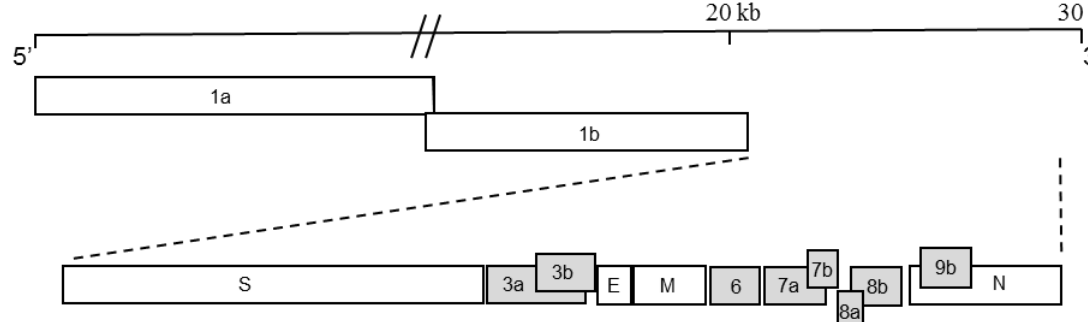
Figure 1. Organization of severe acute respiratory syndrome coronavirus (SARS-CoV) genome showing the position of the accessory genes. The eight accessory open reading frames (ORFs) (grey shaded boxes) encode for ORFs 3a, 3b, 6, 7a, 7b, 8a, 8b and 9b. The ORFs encoding for the replicase genes (ORF 1a and ORF 1b) and structural genes, spike (S), membrane (M), envelope (E) and nucleocapsid (N) are also shown (not drawn to